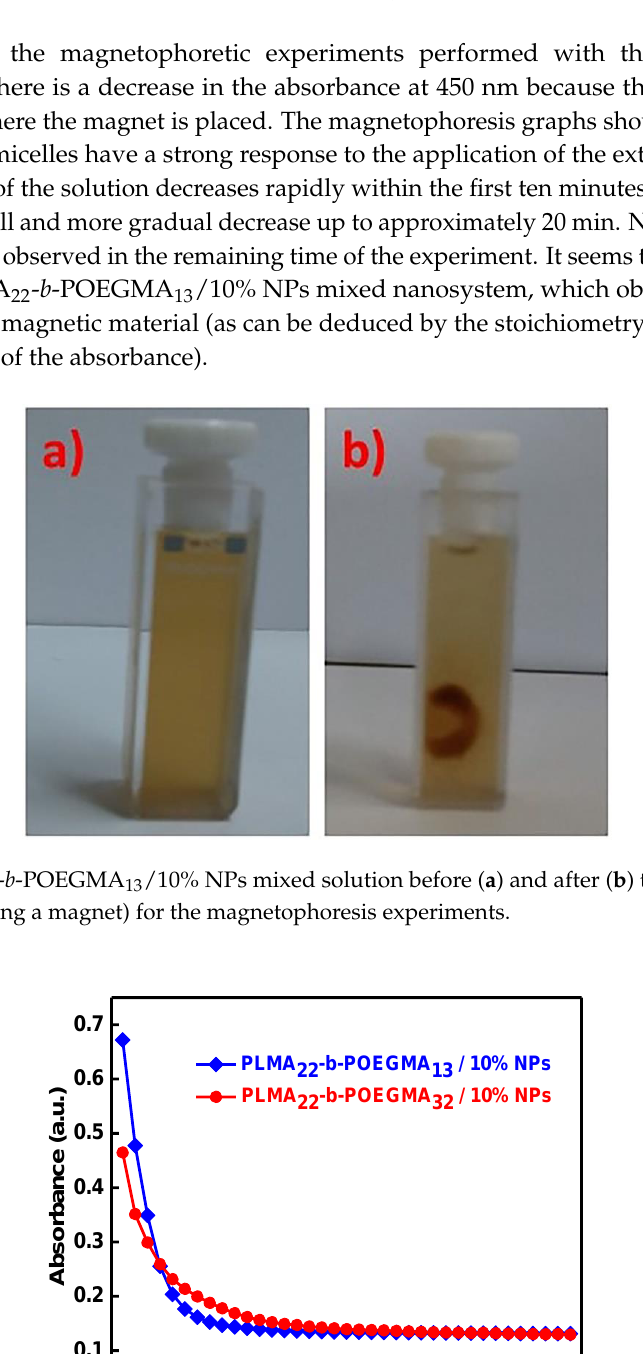
Figure 2. Comparative size distribution graphs from CONTIN analysis before and after the encapsulation of the magnetic NPs within the PLMA 22 -b-POEGMA 13 micelles.